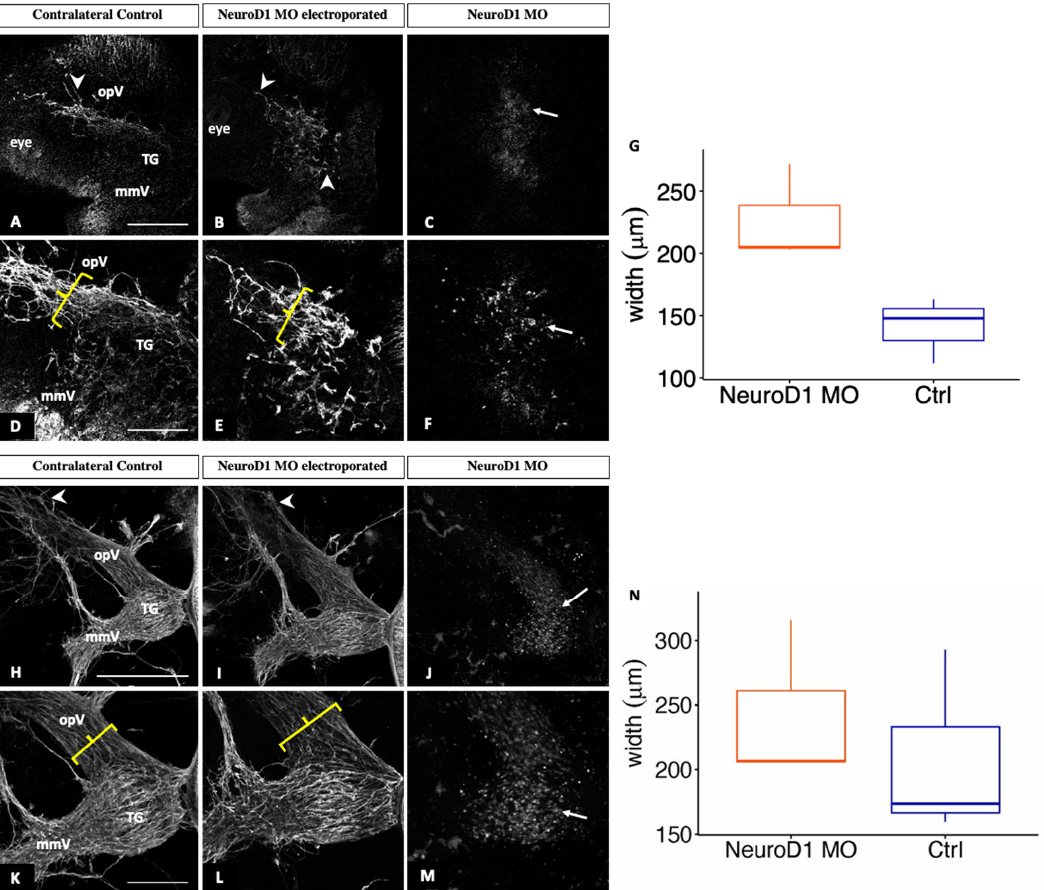
Figure 7. NeuroD1 depletion in trigeminal placode cells disrupts trigeminal ganglion development Lateral view of the trigeminal ganglion in a chick head (E2.5 (HH16), n = 3, ( A – F ) and E3–3.5 (HH19), n = 3, ( H – M )). Representative images are maximum intensity projections of confocal Z-stacks through the contralateral control ( A , D , H , K ) and NeuroD1 MO-electroporated ( B , E , I , L ) sides after processing for whole-mount Tubb3 immunohistochemistry to detect placode-derived neurons ( A , B , D , E , H , I , K , L , arrowheads) and tissue clearing. Bottom rows ( D – F , K – M ) show higher magnification images of their corresponding top rows ( A – C , H – J ). ( C , F , J , M ) MO-positive cells (arrows). Brackets indicate width of ophthalmic branch. ( G , N ) Quantification of the width of the ophthalmic branch on the control (blue) and NeuroD1 MO-treated (orange) sides. Plots represent the median (center line), 75th percentile (top of box), and 25th percentile (bottom of box), with whiskers connecting the largest and smallest values. A paired sample t-test revealed p values of 0.03 at both developmental stages ( G , N ). Scale bar in ( A , D ) is 500 μ m and applies to ( B , C ) and ( E , F ), respec- tively. Scale bar in ( H , K ) is 200 μ m and applies to ( I , J ) and ( L , M ), respectively. Abbreviations: mmV, maxillomandibular lobe; opV, ophthalmic lobe; and TG, trigeminal ganglion.